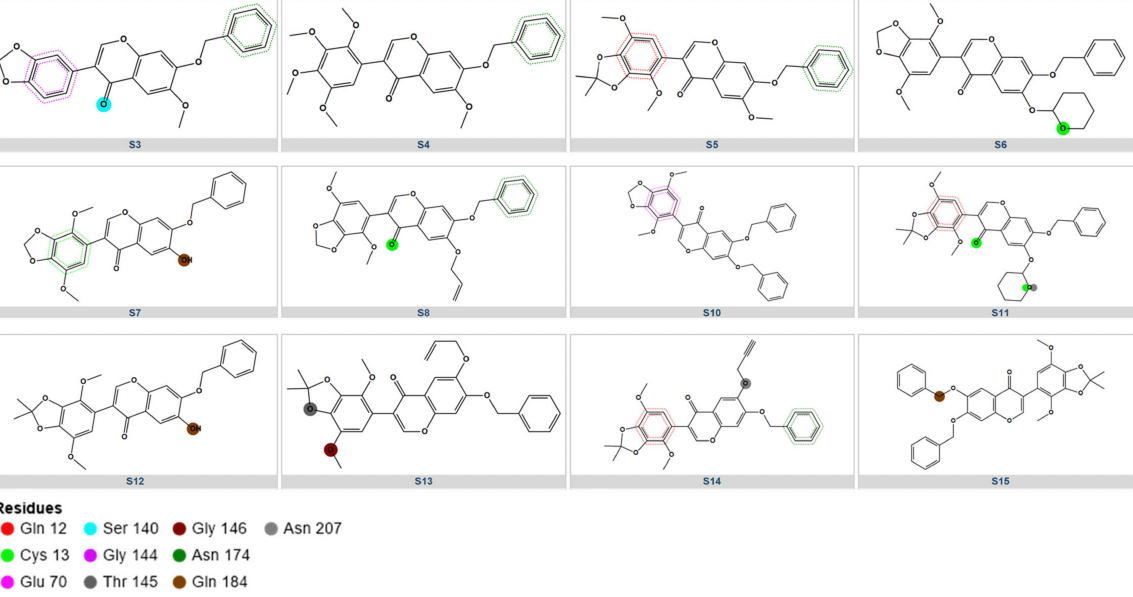
Figure A2. Summary of the interactions of gatastatin derivatives with γ in the GTP-binding